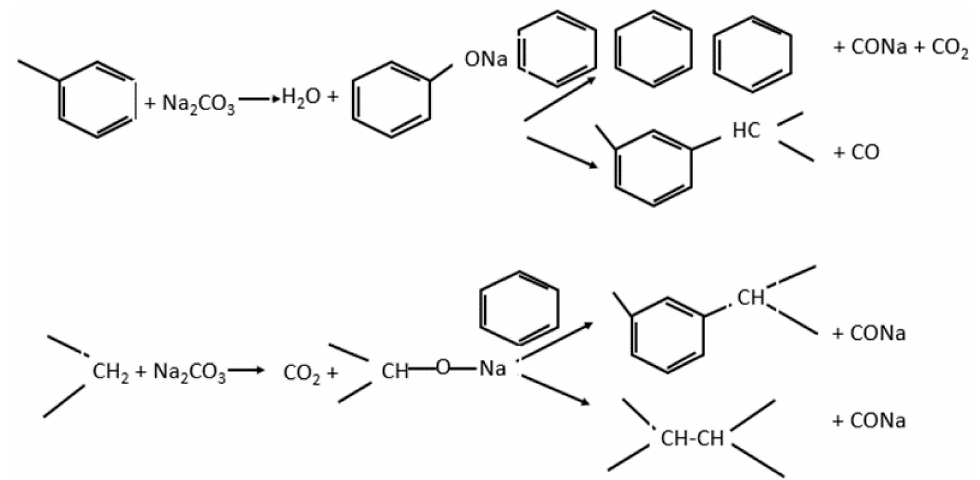
Figure 5. Mechanism of trona during activation